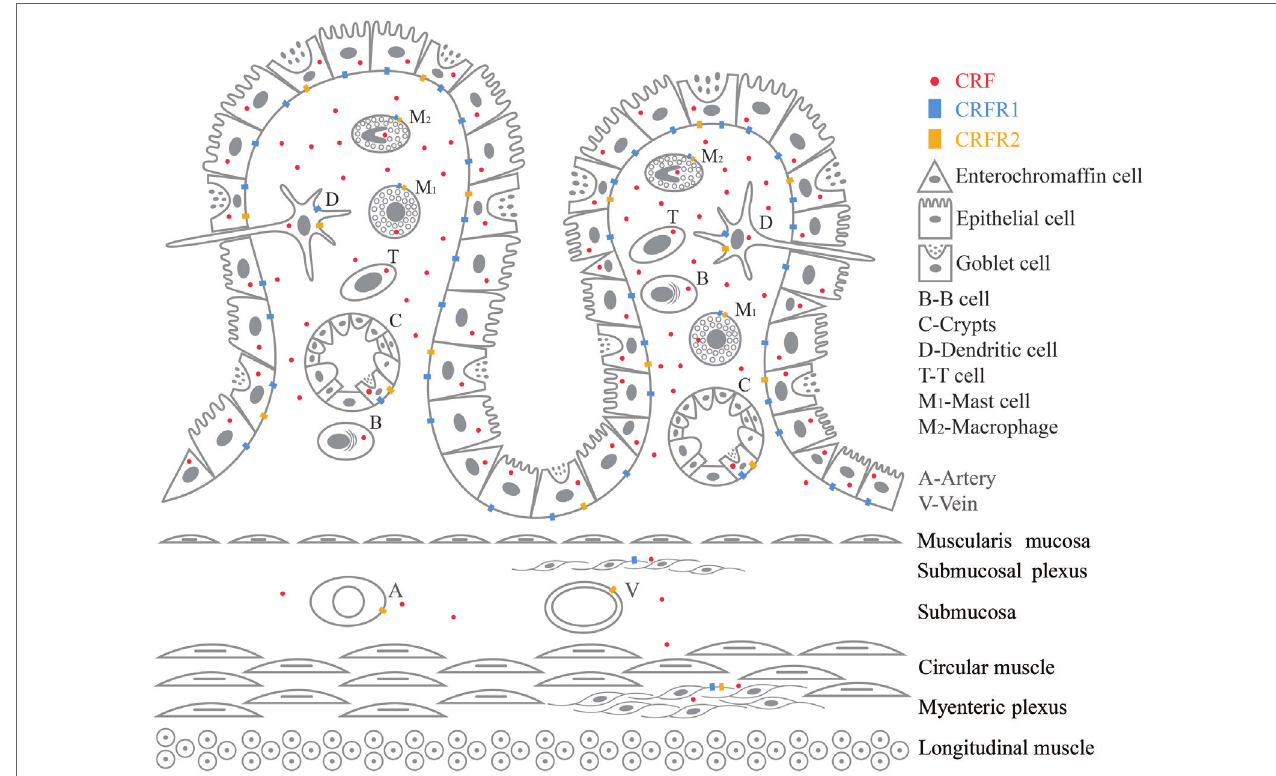
FiGURe 1 | Graphic summary of the expression of CRF, CRFR1, and CRFR2 in GI